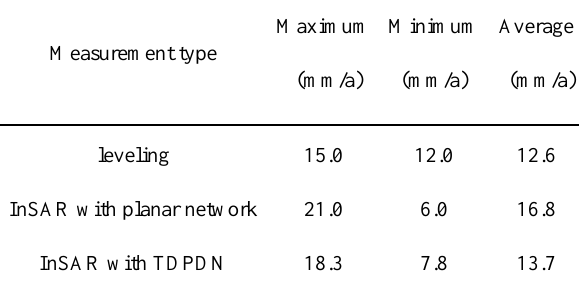
Table 2. Subsidence velocities of 1520 persistent scatter s detected by Leveling and persistent scatter InSAR respectively based on planar network and TDPDN